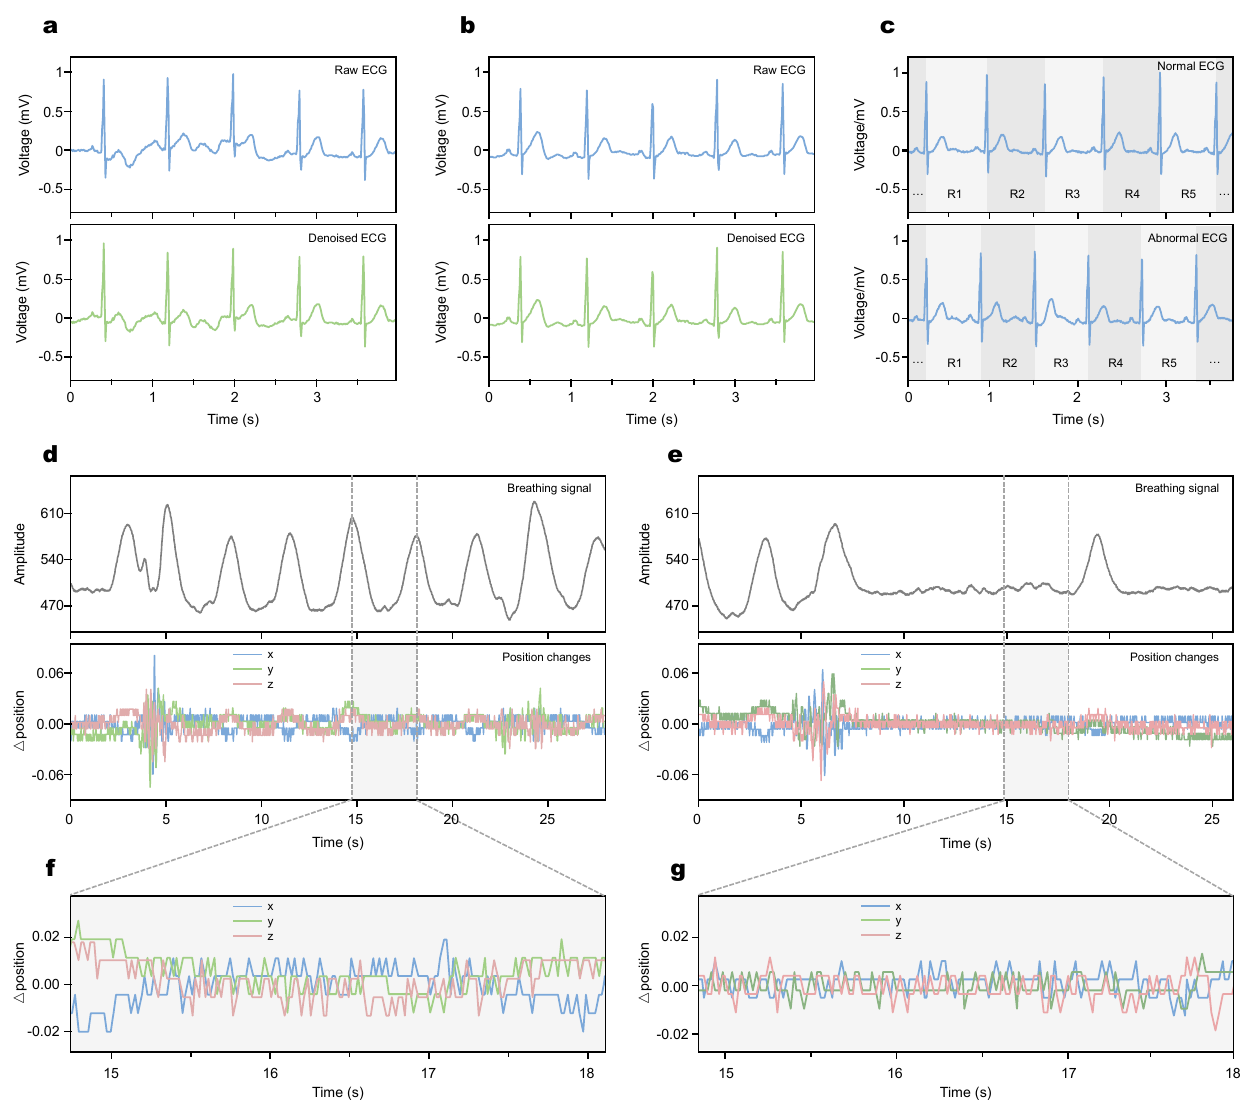
Figure 3. The display of hybrid physiological signal. ( a ) ECG signal before and after denoising at normal breath model. ( b ) ECG signal before and after denoising without apnea occurs. ( c ) ECG signals in normal and apneic RR classification. ( d ) Breathing signal and position signal in normal condition. ( e ) Breathing signal and position signal when apnea occurs. ( f , g ) Details of local fragments of position signals.